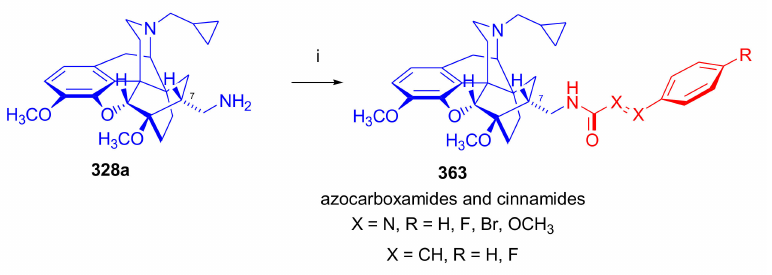
Figure 92. Synthesis of azocarboxamide and cinnamide type 6,14-ethenomorphinan derivatives. Reagents and conditions : (i) (A) substituted phenylazocarboxylate tert -butyl esters (R = H, F, Br, OCH 3 ), K 2 CO 3 , or Et 3 N, EtOH, RT, 3–120 h, 42–87%; or (B) cinnamic acid chlorides (R = H, F), NaHCO 3 , CH 2 Cl 2 , RT, 28 h,